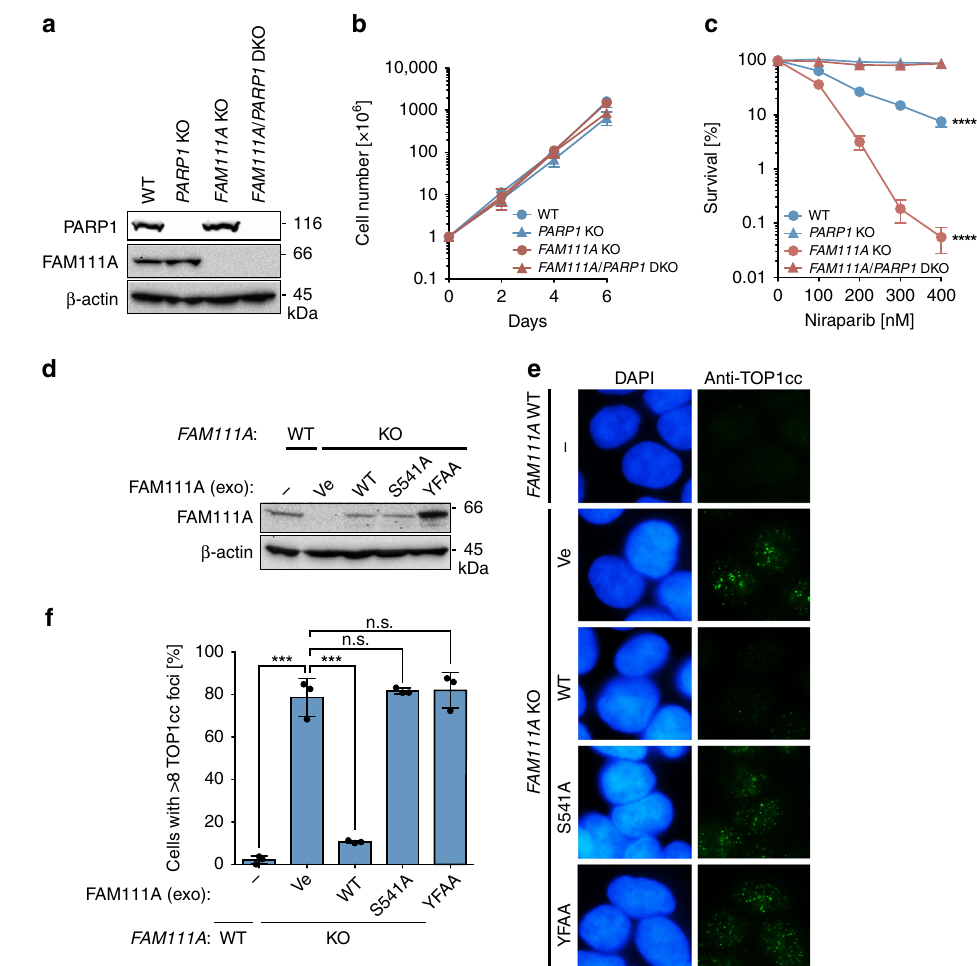
Fig. 4 FAM111A KO causes trapping-dependent PARPi sensitization and TOP1cc accumulation. a Knockout of PARP1 by CRISPR/Cas9. Parental HAP1 (WT), PARP1 KO #17, FAM111A KO #14, FAM111A/PARP1 double knockout (DKO) #1 were analyzed for expression of the indicated proteins by Western blotting. b Cell proliferation assays. Cells analyzed in a were cultured and cell numbers were counted every other day up to 6 days. Values are mean ± s.d. of independent experiments ( n = 3). c Clonogenic survival assays. Cells analyzed in a were cultured in the presence of the indicated concentrations of niraparib for 6 days. Results shown are representative of three independent experiments and values represent mean±s.d. of technical replicates ( n = 3). p values were calculated between WT and PARP1 KO and between FAM111A KO and FAM111A/PARP1 DKO, respectively. **** p <0.0001 (two-tailed unpaired t -test). d Exogenous (exo) expression of WT and mutant FAM111A proteins in FAM111A KO cells. The indicated FAM111A proteins were stably expressed by lentiviral vectors in FAM111A KO #14 and analyzed by Western blotting. Parental HAP1 (WT) is shown as a reference. Ve empty vector. e TOP1cc focus formation. Cells analyzed in d were stained with anti-TOP1cc antibody and DAPI. Scale bar, 5 µ m. f Quanti fi cation of cells containing TOP1cc foci. Experiments were performed as in e . At least 100 cells were scored by an investigator blinded to sample identity and percentages of cells with 8 or more foci are shown. Values are mean±s.d. of